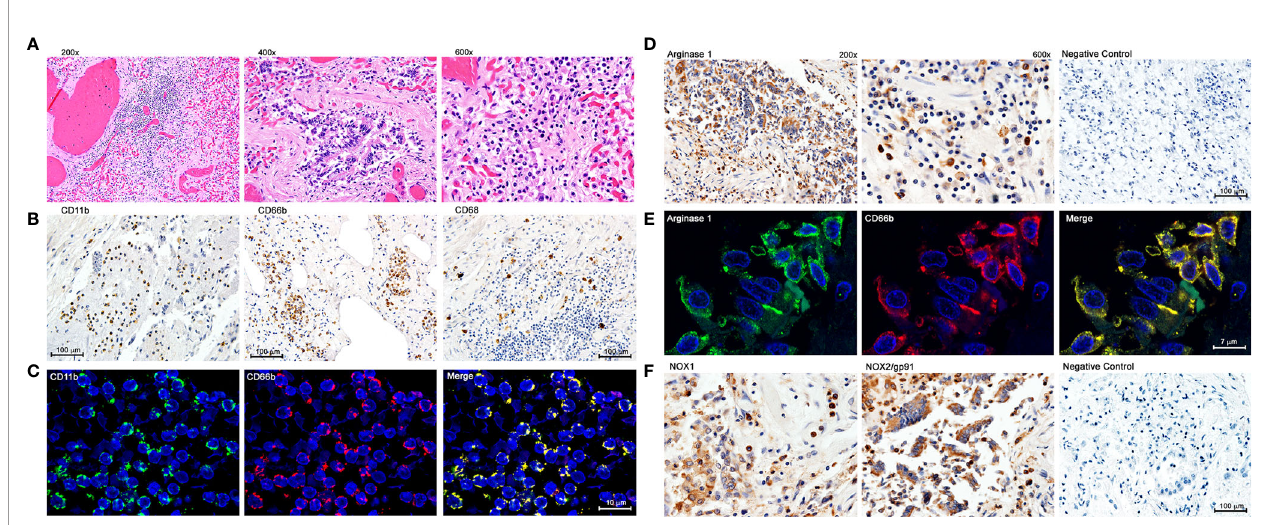
FIGURE 2 | Immunohistochemistry and Double Immuno fl uoresence of In fl ammatory In fi ltrates in Lung Autopsy Samples. (A) Hematoxylin & Eosin staining. (B) Immunohistochemistry with anti-CD11b, CD66b and CD68. (C) Double immuno fl uorescence with anti-CD11b and anti-CD66b. (D) Immunohistochemistry for Arginase 1. (E) Double immuno fl uorescence with anti-Arginase 1 and anti-CD66b; (F) Immunohistochemistry with anti-NOX1 and